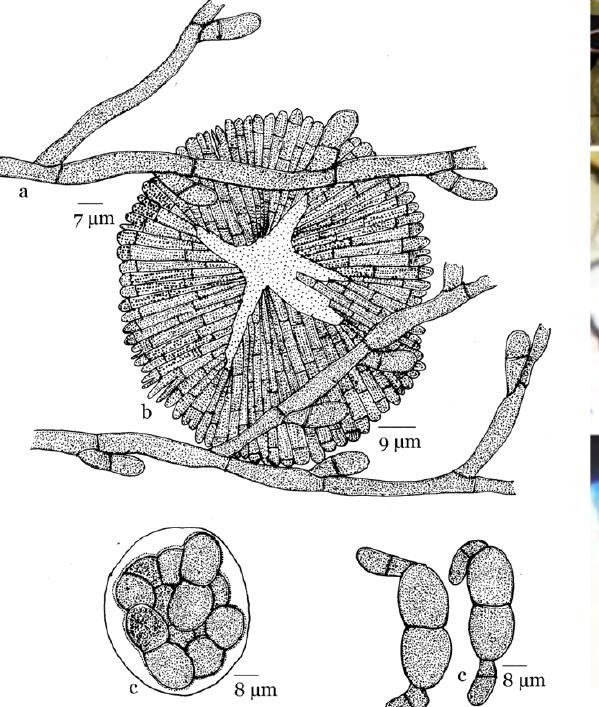
Image 14. Asterina jambolana 1 - Infected leaves; 2 - Thyriothecia; 3 - Appressoriate mycelium; 4 - Asci in the Ascomata; 5 - Asci; 6 -